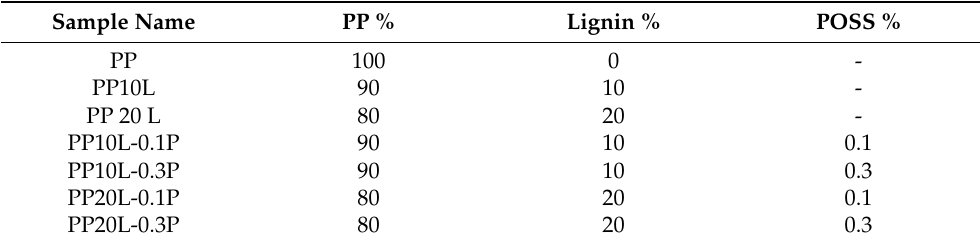
Figure 2. General procedure for fabrication of a blend sponge. Table 2. Fabricated composites and their sample